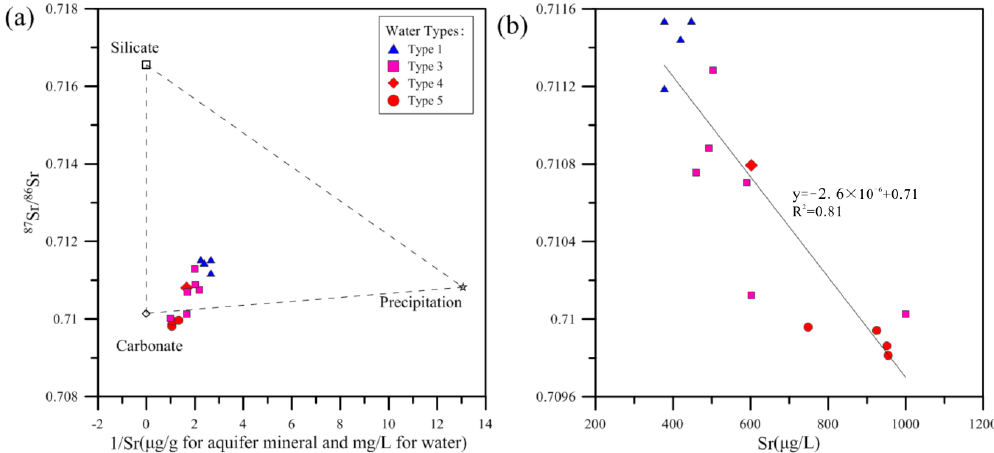
Figure 10. ( a ) The plot of 87 Sr/ 86 Sr ratio versus 1/Sr of the groundwater: Three end-members are also shown. ( b ) The plot of 87 Sr/ 86 Sr ratio versus Sr concentration of groundwater.